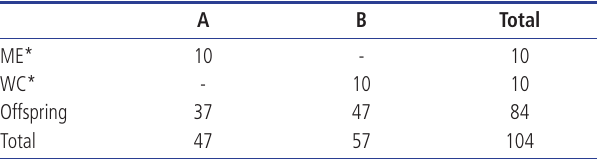
Table 1. Frequency of genotypes of OGT among ME and WC boars, and boars